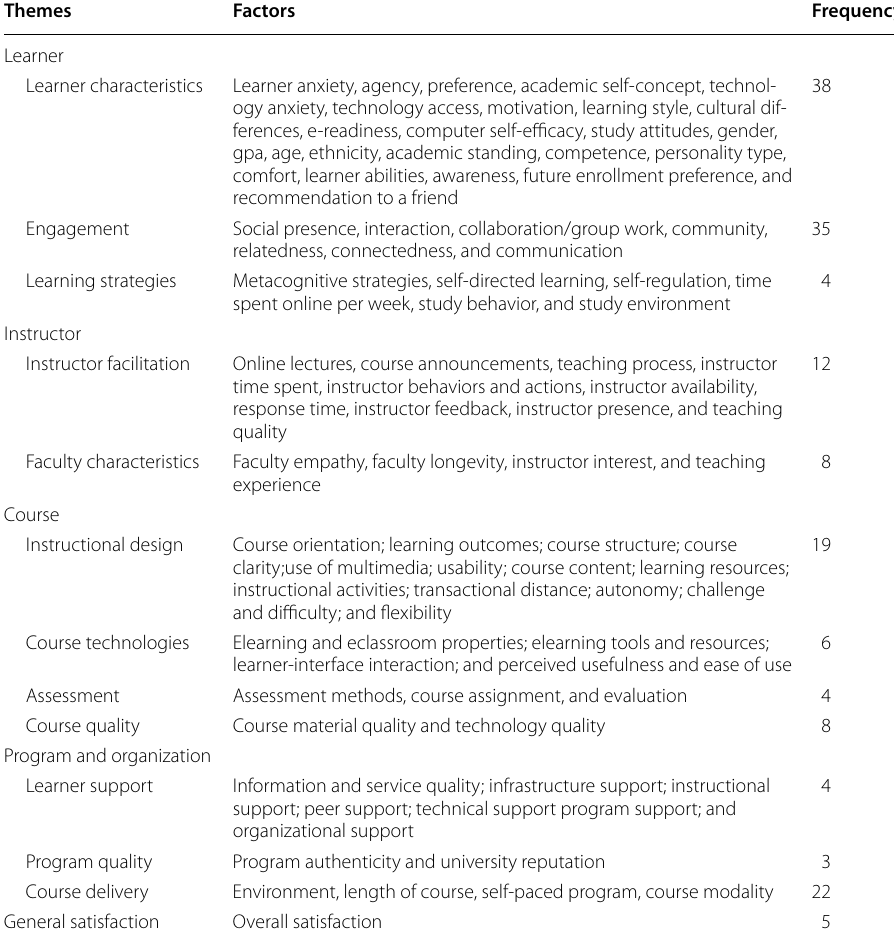
Table 9 Online learner satisfaction research themes and